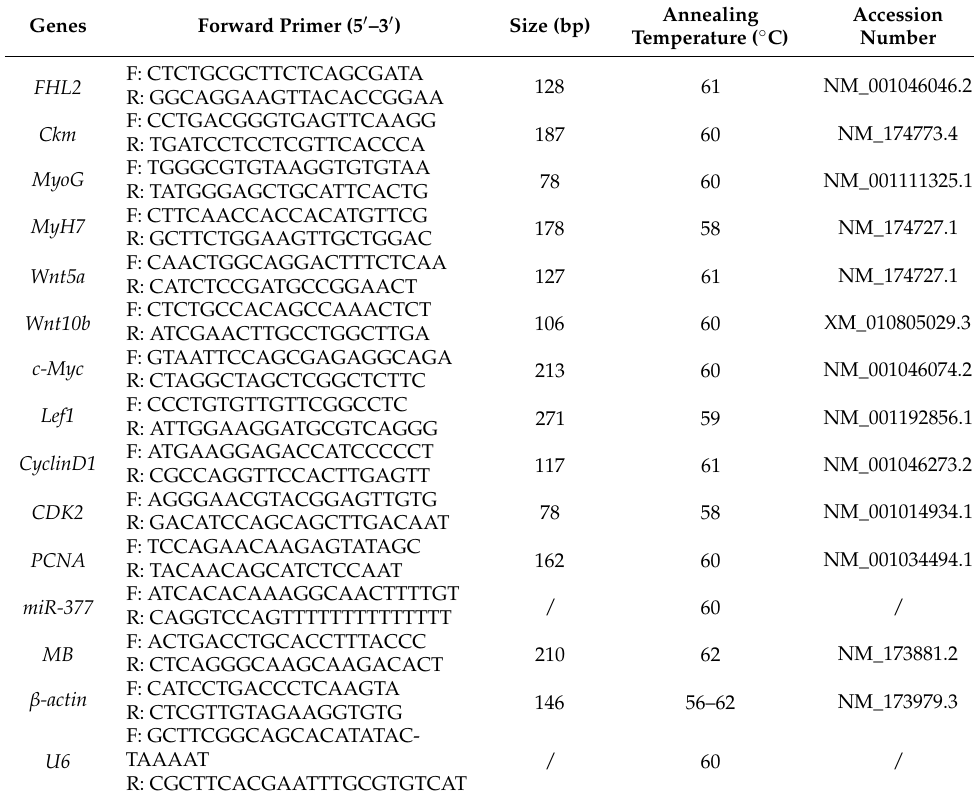
Table 2. Primer information for quantitative real-time PCR